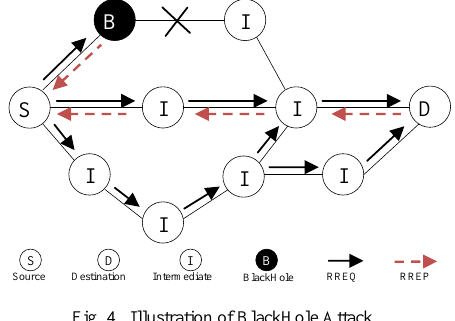
Fig. 4. Illustration of BlackHole Attack